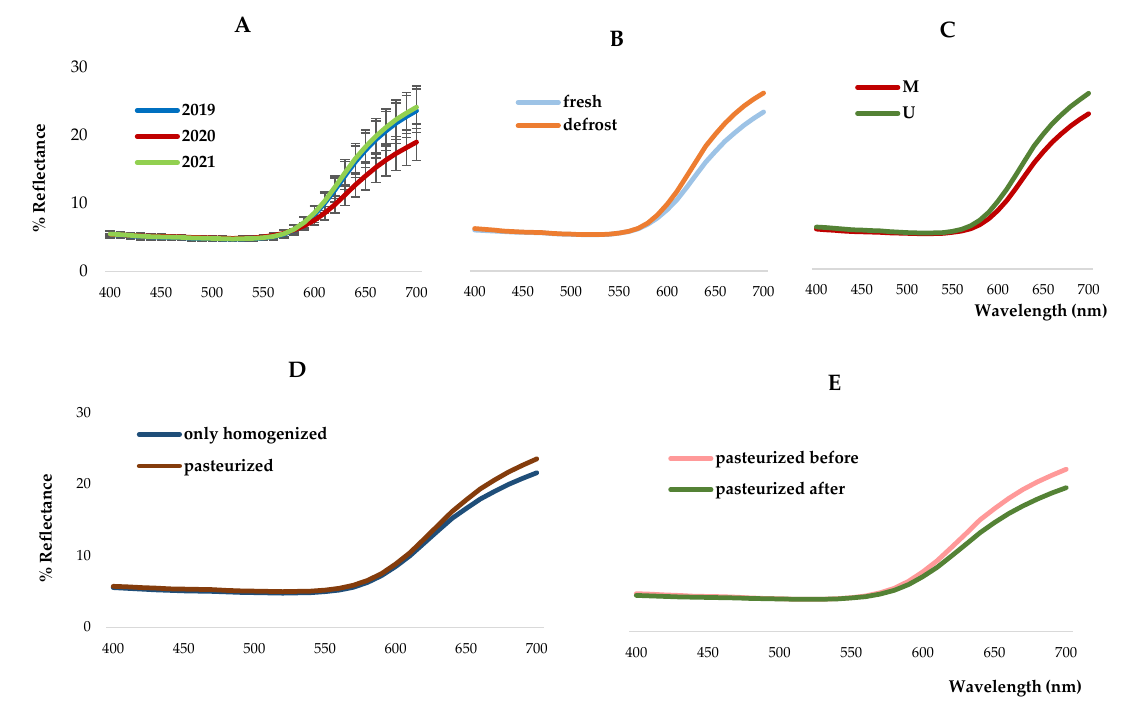
Figure 1. Comparison among reflectance curves of sample clusters. ( A ): mean reflectance curves ± SD of all samples coming from the same harvest year. ( B – E ): mean reflectance value of samples belonging to different vintage but subjected to the same procedures.